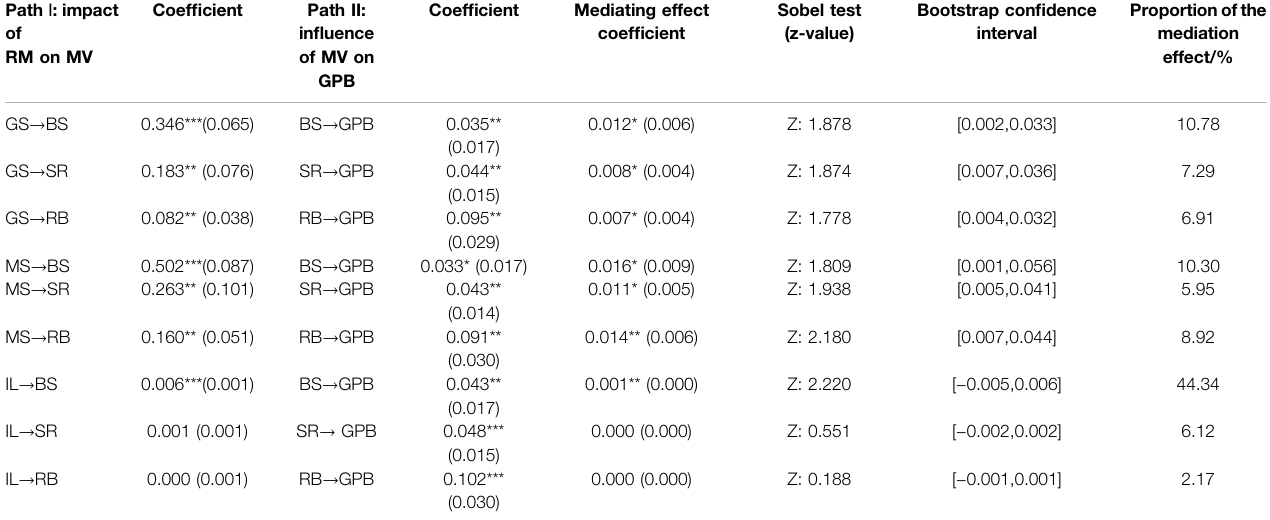
The standard errors are in brackets, and the estimation results of the other control variables are omitted.